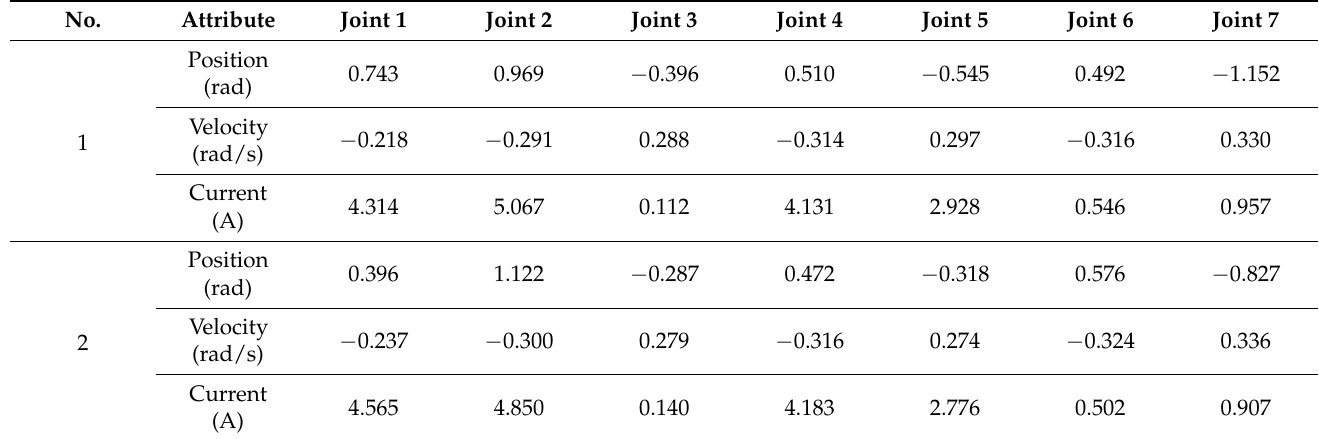
Table 1. Example of data from a subscription